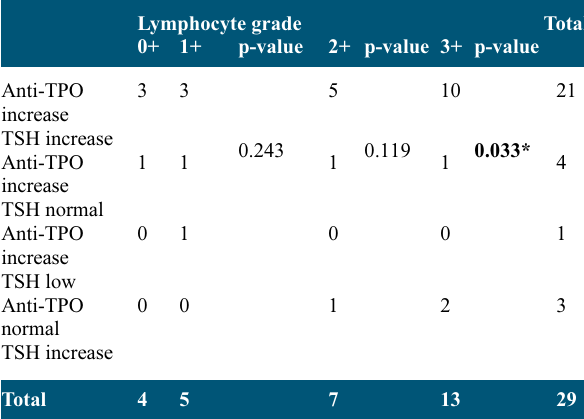
Table 6: Grading of autoimmune thyroiditis and correlation of grading of autoimmune thyroiditis with anti-TPO and TSH